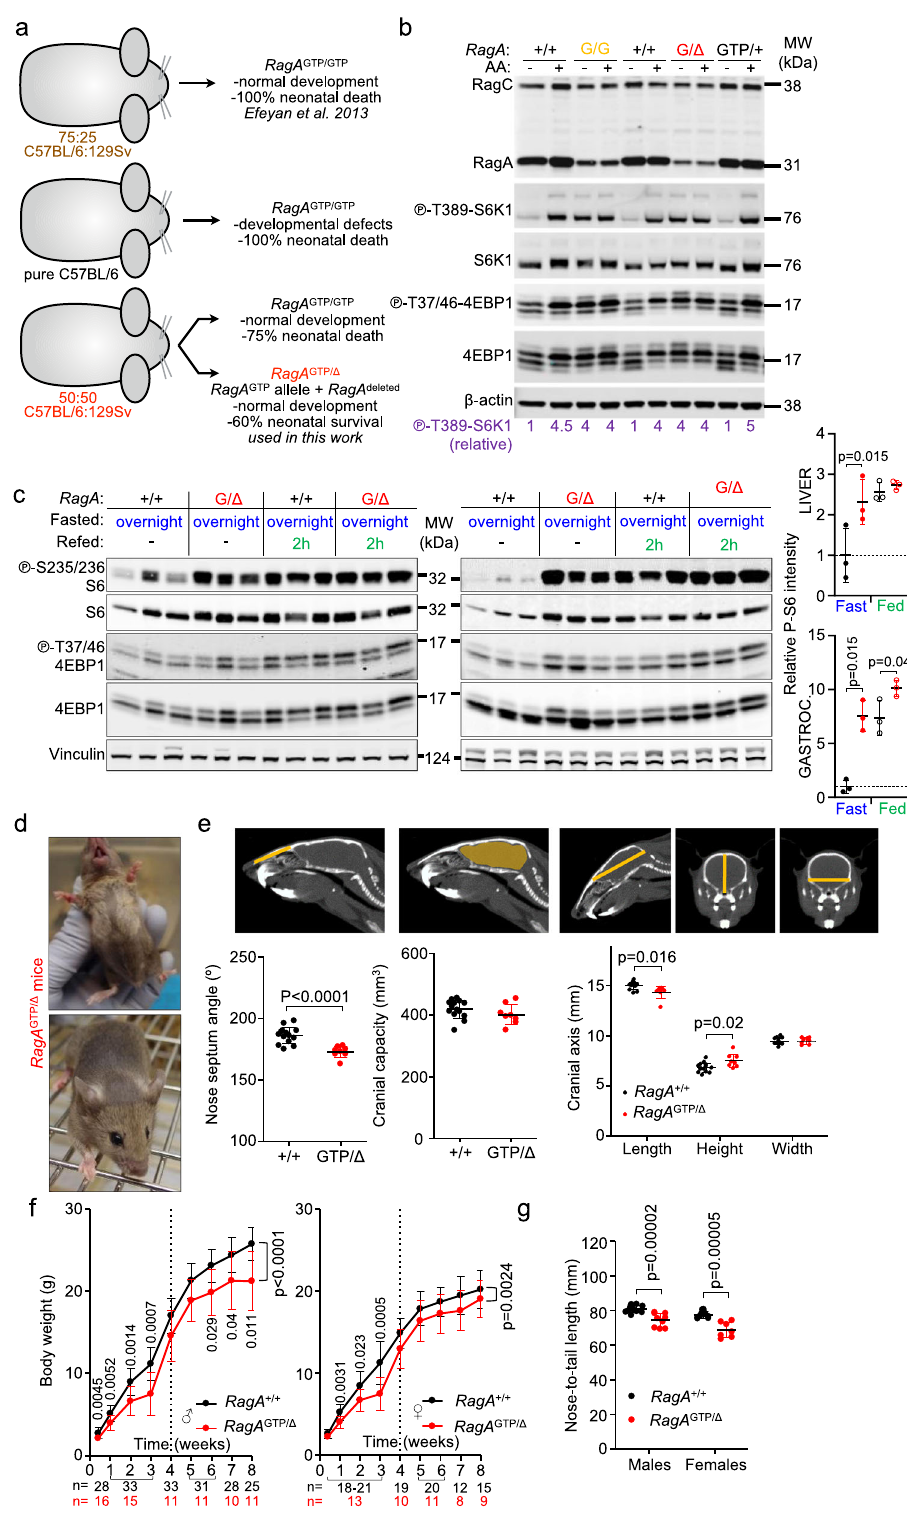
gastrocnemius (Fig. 1c), and in kidney and heart (Supplementary Fig. 1e), but not as strong in white and brown adipose tissues (Supplementary Fig. 1f). Noteworthy, upon refeeding, the max- imal phosphorylation of mTORC1 targets was similar in most organs from RagA + / + and RagA GTP/ Δ mice (Fig. 1c and Sup- plementary Fig. 1e, f), suggesting that genetic activation of the nutrient signaling pathway results in resistance to inhibition by